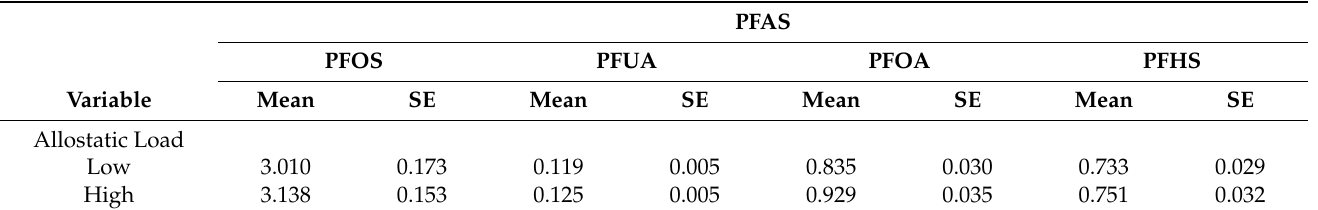
Table 4. Summary differences in participants’ serum PFAS (PFOS, PFUA, PFOA, PFHS) concentra- tions (ng/mL) by Allostatic Load. PFAS PFUA PFOA